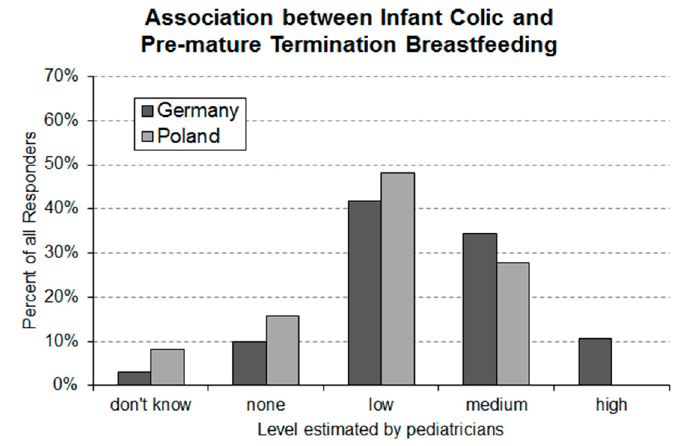
Figure 4. Level of association between infantile colic and premature termination of breastfeeding estimated by German ( n = 159) and Polish ( n = 133) pediatricians. An asymptotic Linear-by-Linear Association Test of the data revealed a highly significant ( p -value = 0.000317) between-country difference.